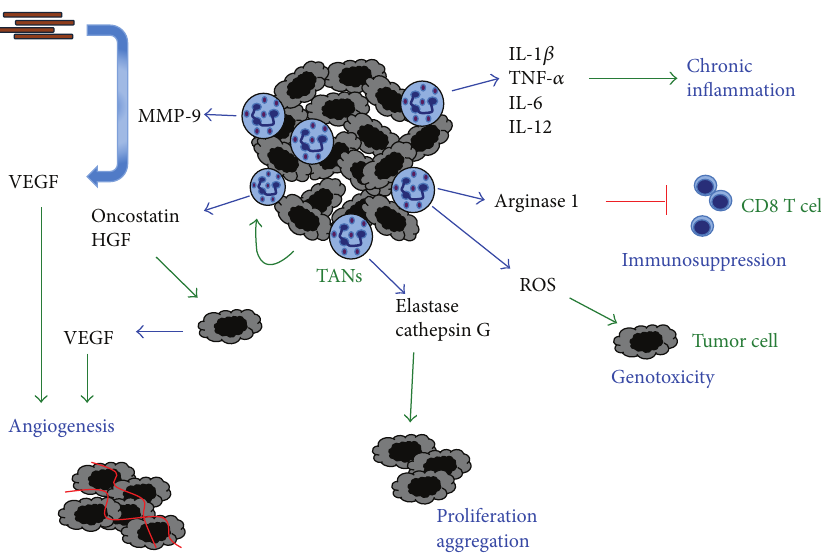
Figure 2: Protumor activity of neutrophils. Tumor-associated neutrophils (TANs) help tumor progression in several ways. TANs can secrete matrix metalloproteinase-9 (MMP-9) that releases vascular endothelial growth factor (VEGF) from the extracellular matrix (ECM) to promote angiogenesis. TAN can secrete cytokines (IL-1 𝛽 , TNF- 𝛼 , IL-6, and IL-12) that induce a chronic inflammatory state and arginase 1, which inhibits CD8 T cells, creating an immunosuppressive state. TANs also produce reactive oxygen species (ROS) that can damage DNA, inducing genotoxic effects on tumor cells. Serine proteases, such as elastase and cathepsin G, from neutrophil granules seem to have a direct effect on tumor cells for inducing proliferation. Certain tumors, like breast cancer cells, induce neutrophils to produce Oncostatin, an IL-6- like cytokine that then stimulates breast cancer cells to secrete vascular endothelial growth factor to promote angiogenesis (red lines represent new blood vessels). Also, hepatocellular carcinoma cells induce neutrophils to release hepatocyte growth factor (HGF), which activates tumor cells to become more invasive. Blue arrows denote molecules secreted by cells. Green arrows denote the action of molecules on